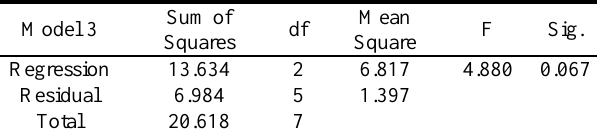
Tab.8. The regression coefficient of regression model 2 Unstandardized